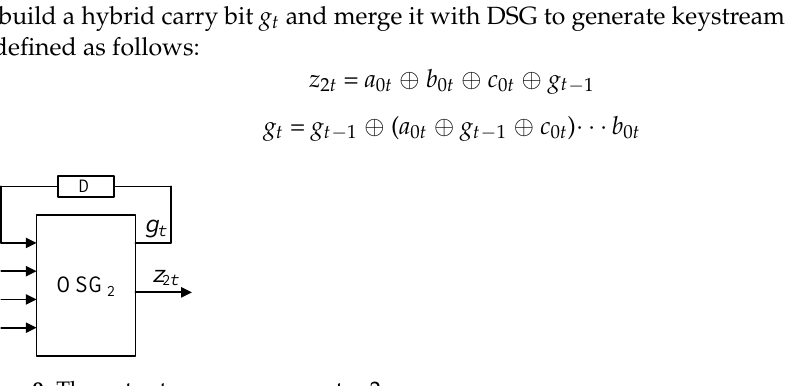
Figure 9. The output sequence generator 2.